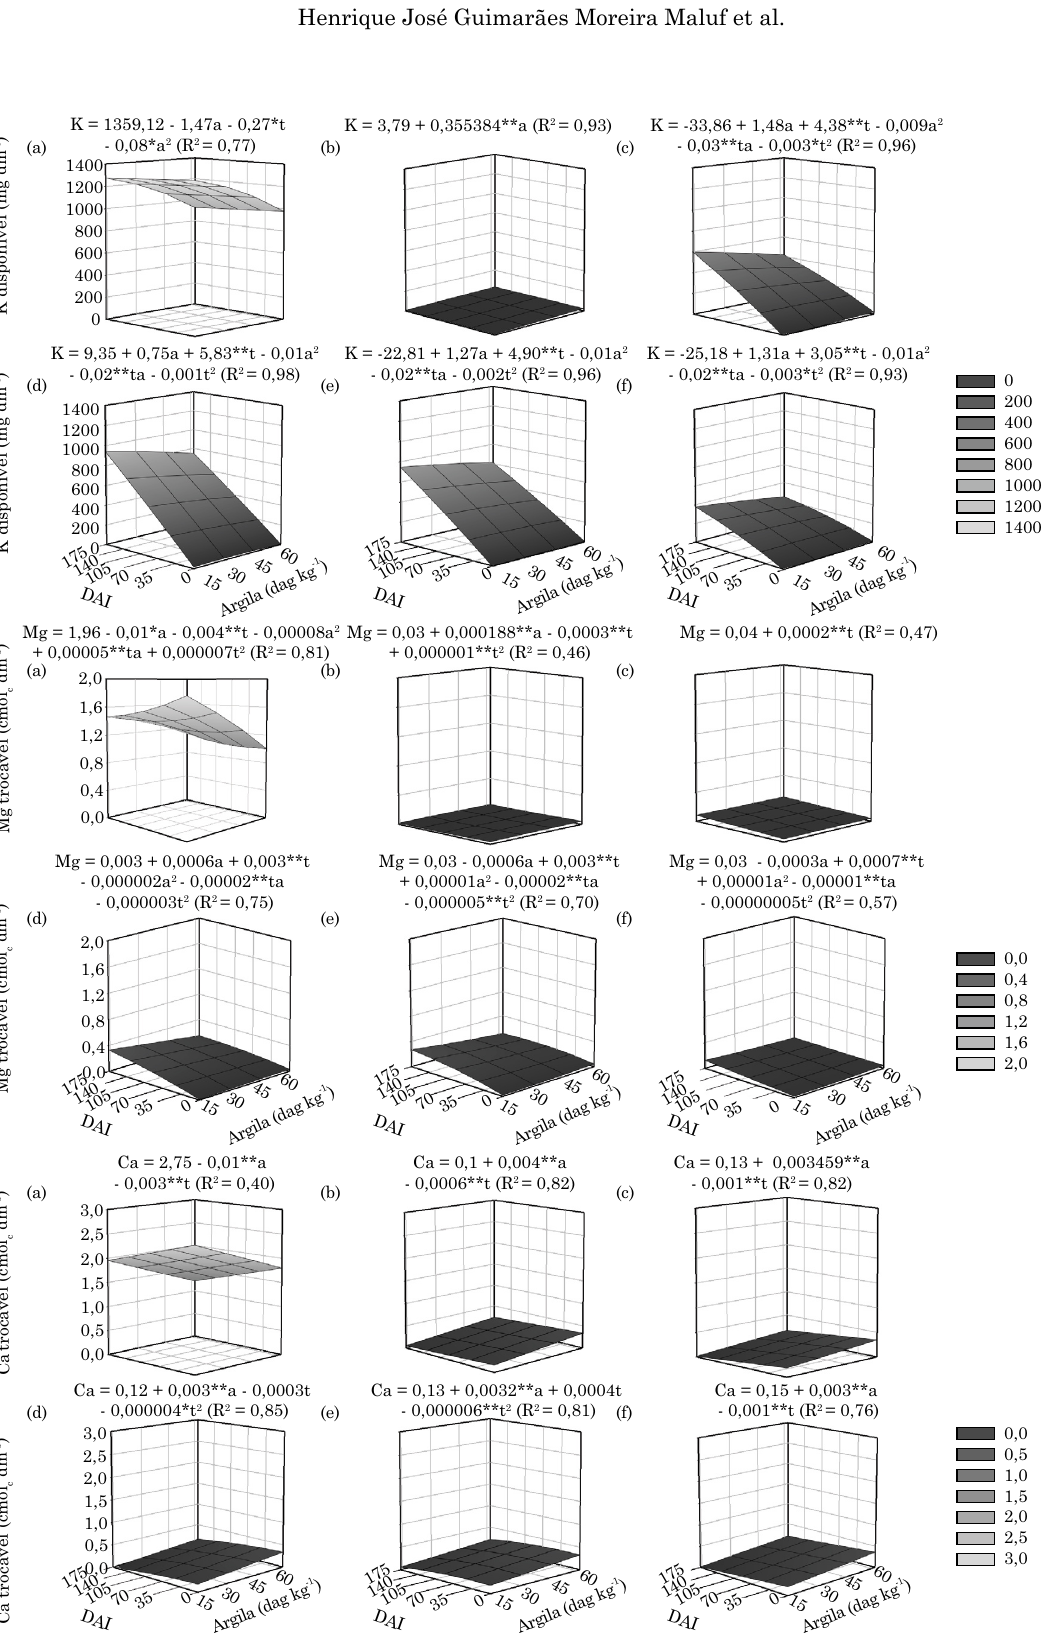
figura 3. teores de K disponível (mehlich-1) e mg e ca trocáveis (Kcl) nos solos com fontes inorgânicas dos nutrientes (a), sem adição de nutrientes e resíduo (b); e com resíduo de: milho (c), braquiária (d), feijão (e) e estilosantes (f). * e **: significativos a 5 e 1 %, respectivamente, referentes às